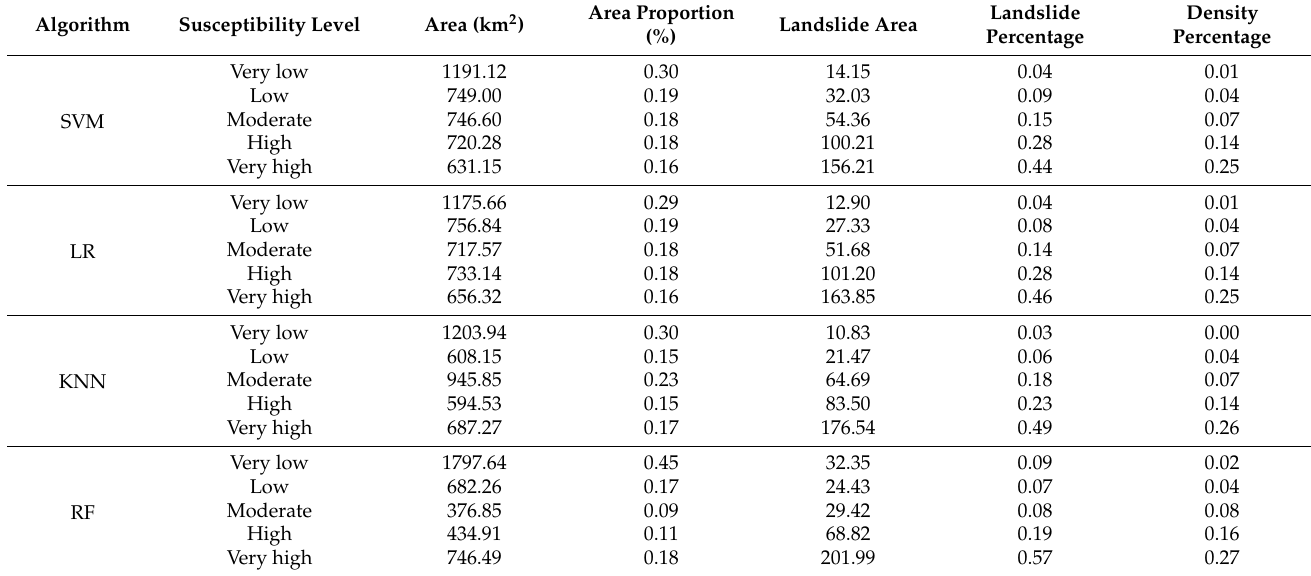
Table 4. Comparison of each susceptibility class for the different